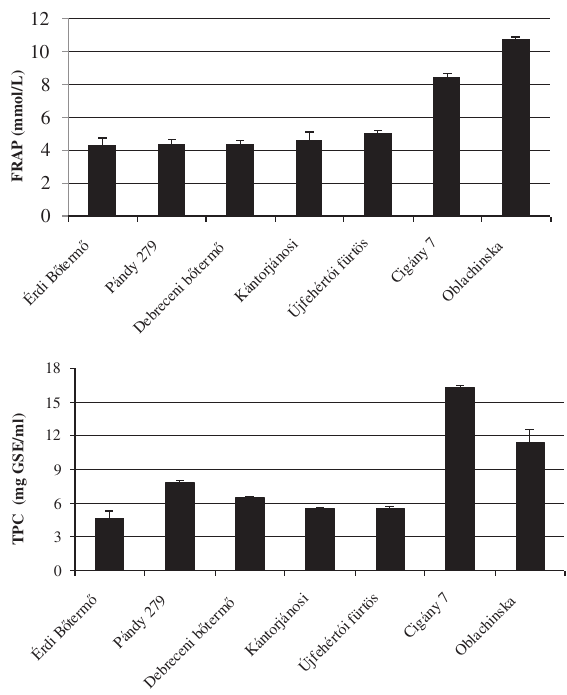
Figure 4. Antioxidant capacity and total phenol content of sour cherry juices